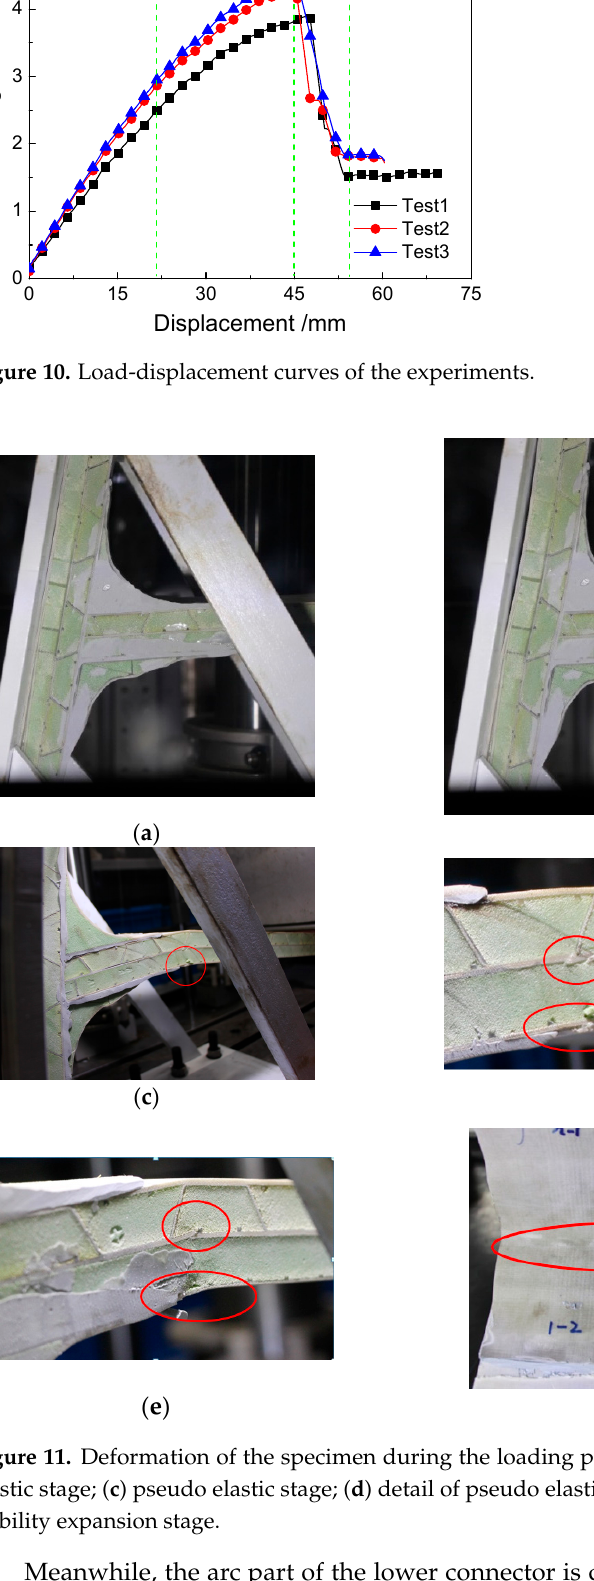
Figure 10. Load-displacement curves of the experiments.